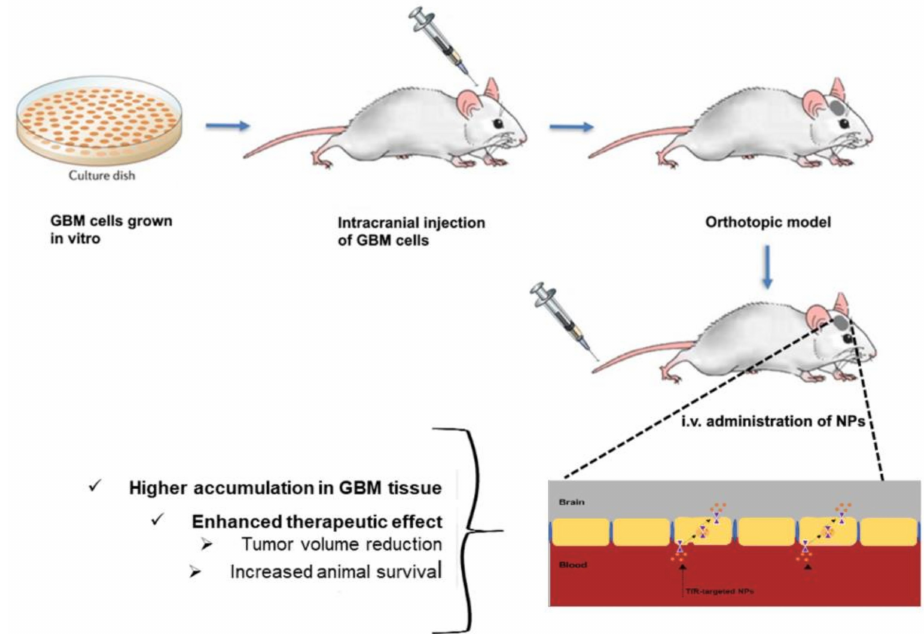
Figure 5. Schematic representation of intracranial tumor mice establishment for TfR-targeted NPs